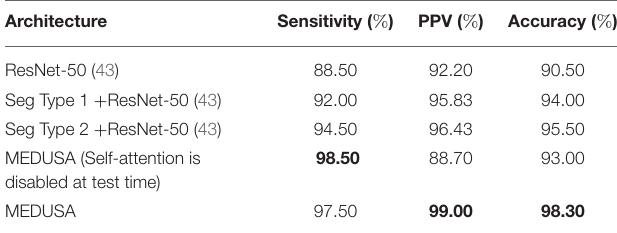
TABLE 3 | Ablation study. Sensitivity, positive predictive value (PPV), and accuracy from the ablation study for the proposed network (MEDUSA) in comparison to other networks.